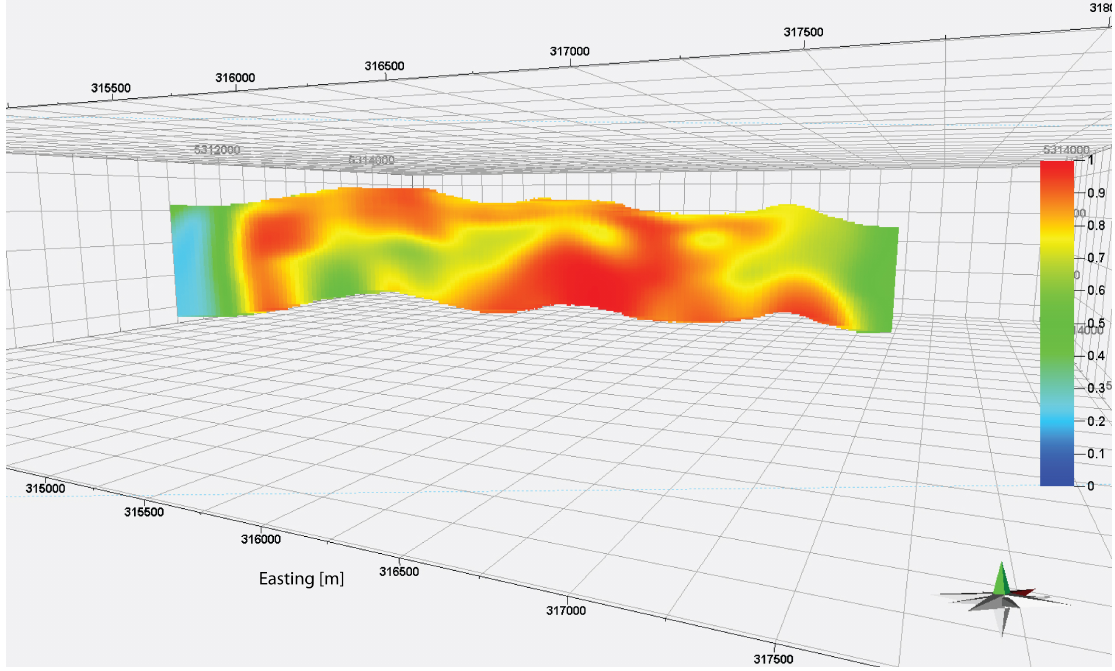
Figure 15. A vertical cross section of the 3D relaxation parameter model recovered from 3D inversion of the pole–dipole IP data along Line